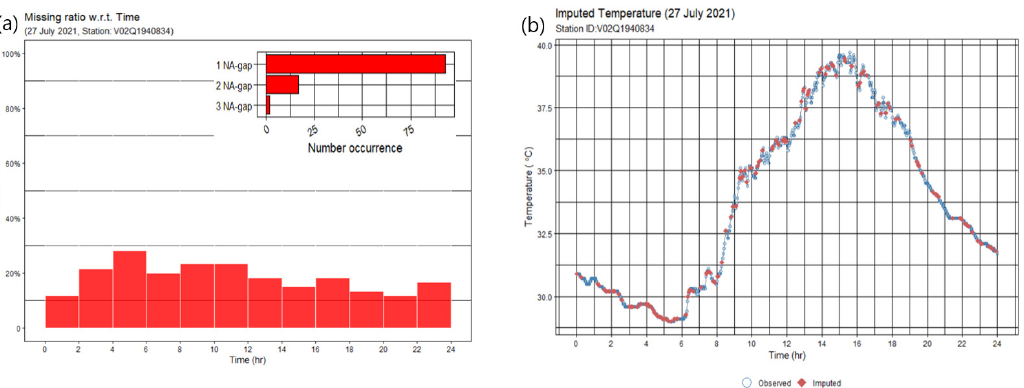
Figure 9. ( a ) Histogram of the number of NA (Not Available) data with respect to the time of a day, and ( b ) time series of observed (blue open circle) and imputed (red diamond) data on 27 July 2021 at a station.